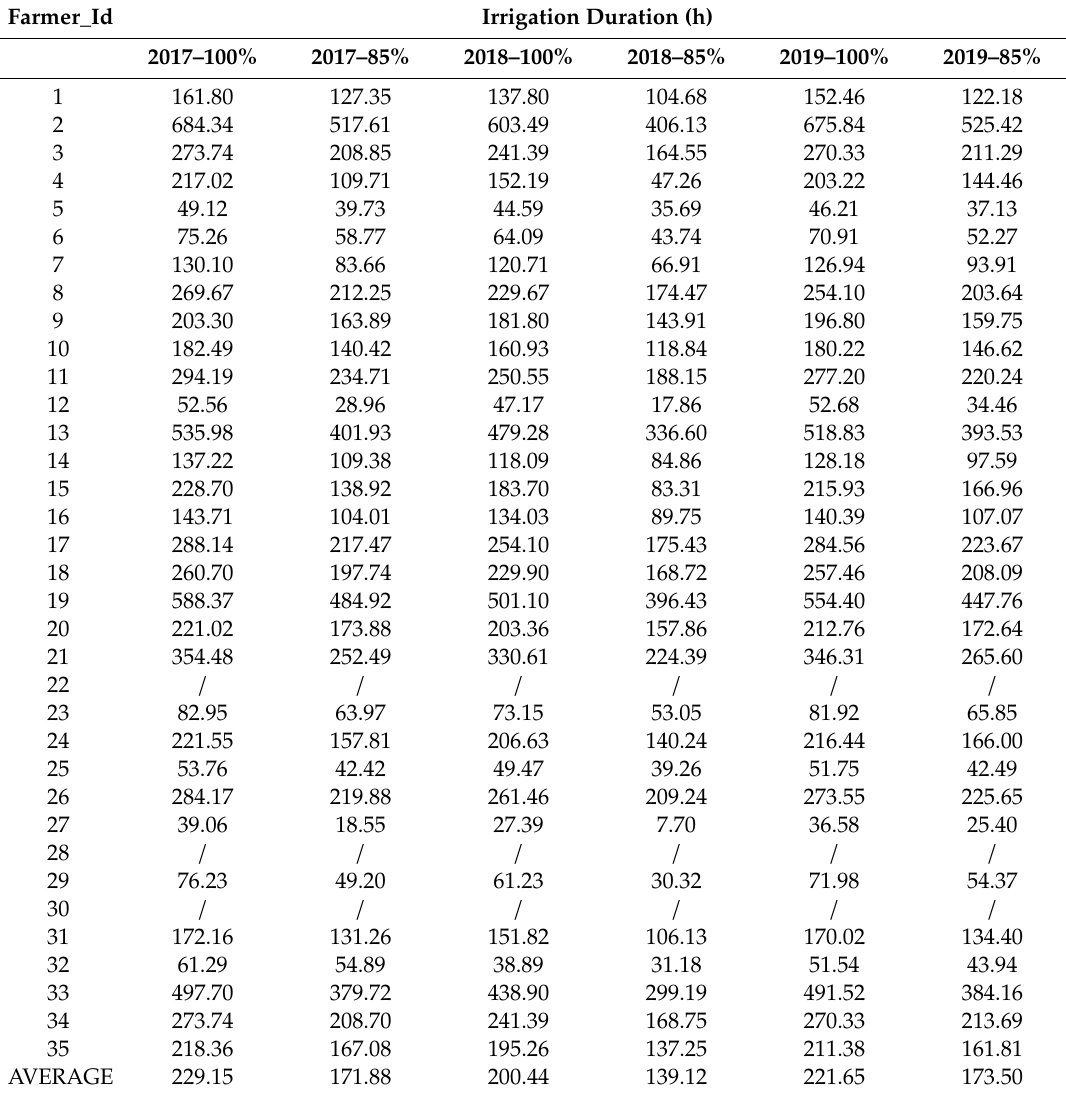
Table A7. Yearly irrigation duration (h) at farm level by replenishing soil water content to (i) FC and (ii) to 85% capacity